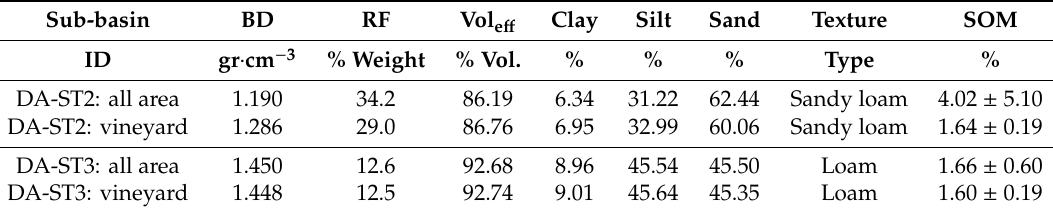
Table 3. Physical and chemical soil parameters in the drainage area of the two sediment traps.